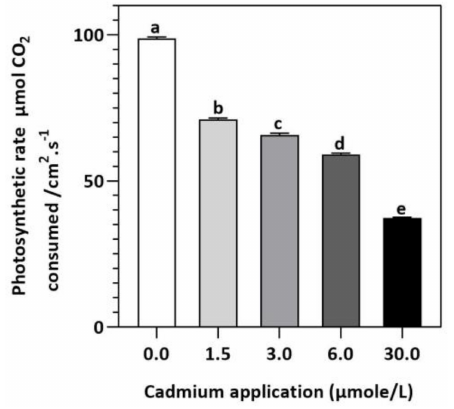
Figure 2. E. sativa photosynthesis rate after Cd application. Each data value is presented at mean ± SE (n = 5). Under Tukey’s multiple range test, different letters indicate significant differences ( p <